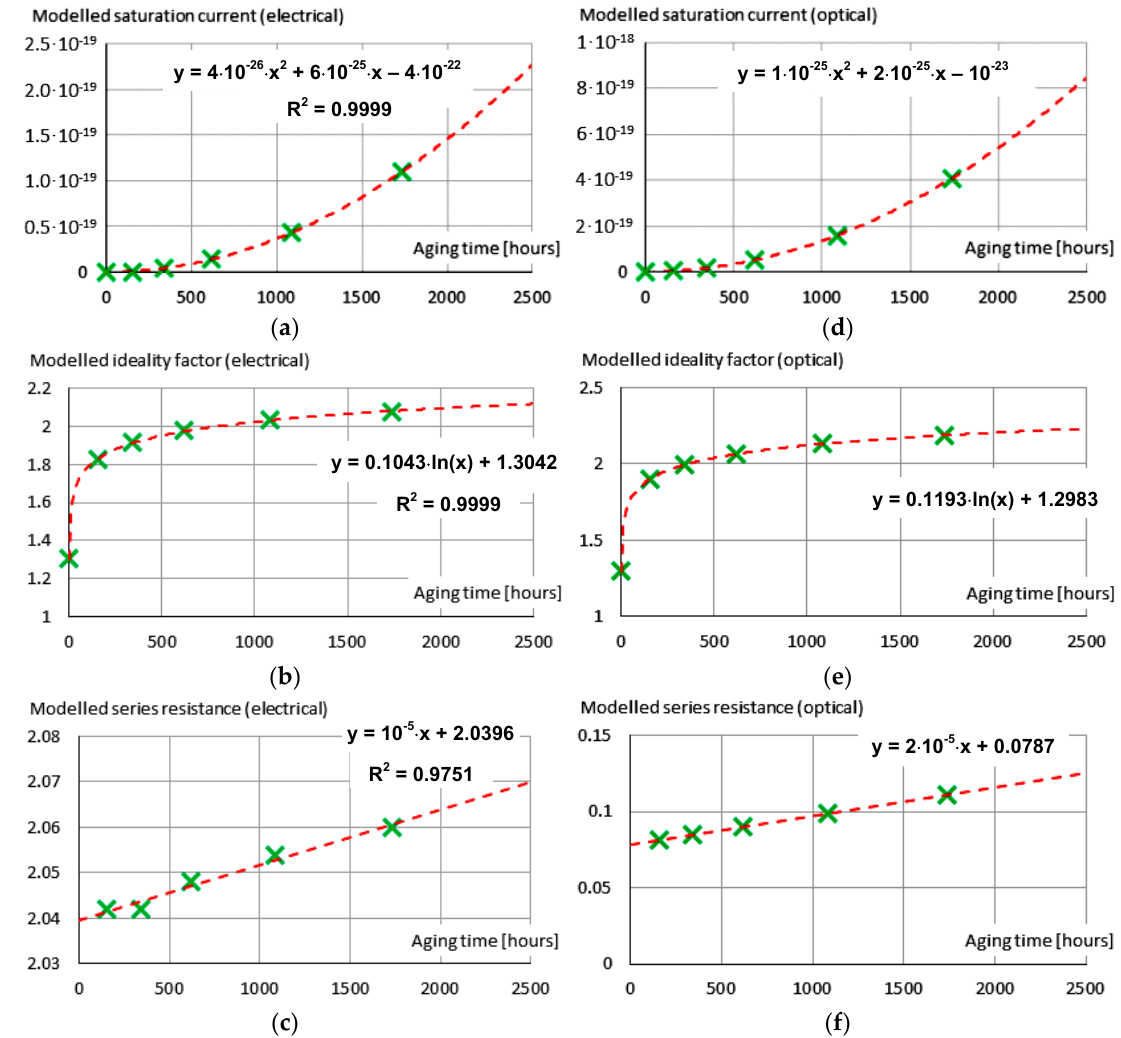
Figure 16. Electrical ( a – c ) and optical ( d – f ) model parameters of #S07.